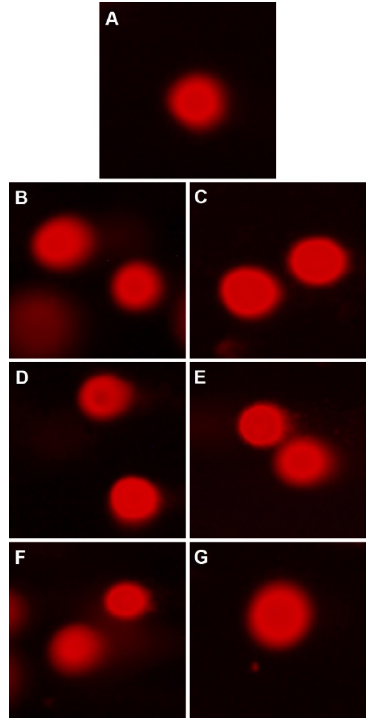
Figure 5. Comet assay of γ -Fe 2- x Y x O 3 performed on MRC-5 cell line. ( A ) Control; ( B ) x = 0; ( C ) x = 0.005; ( D ) x = 0.011; ( E ) x = 0.014; ( F ) x = 0.028 and ( G ) x = 0.031.